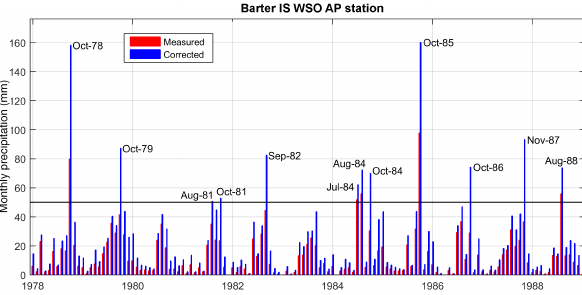
Figure 4. Comparison of the catch ratio of snowfall as a function of wind speed at gauge height for the Alter-shielded or unshielded NWS 8in. standard gauge and the Canadian Nipher snow gauge. DFIR is the Double Fence Intercomparison Reference (Yang et al.,